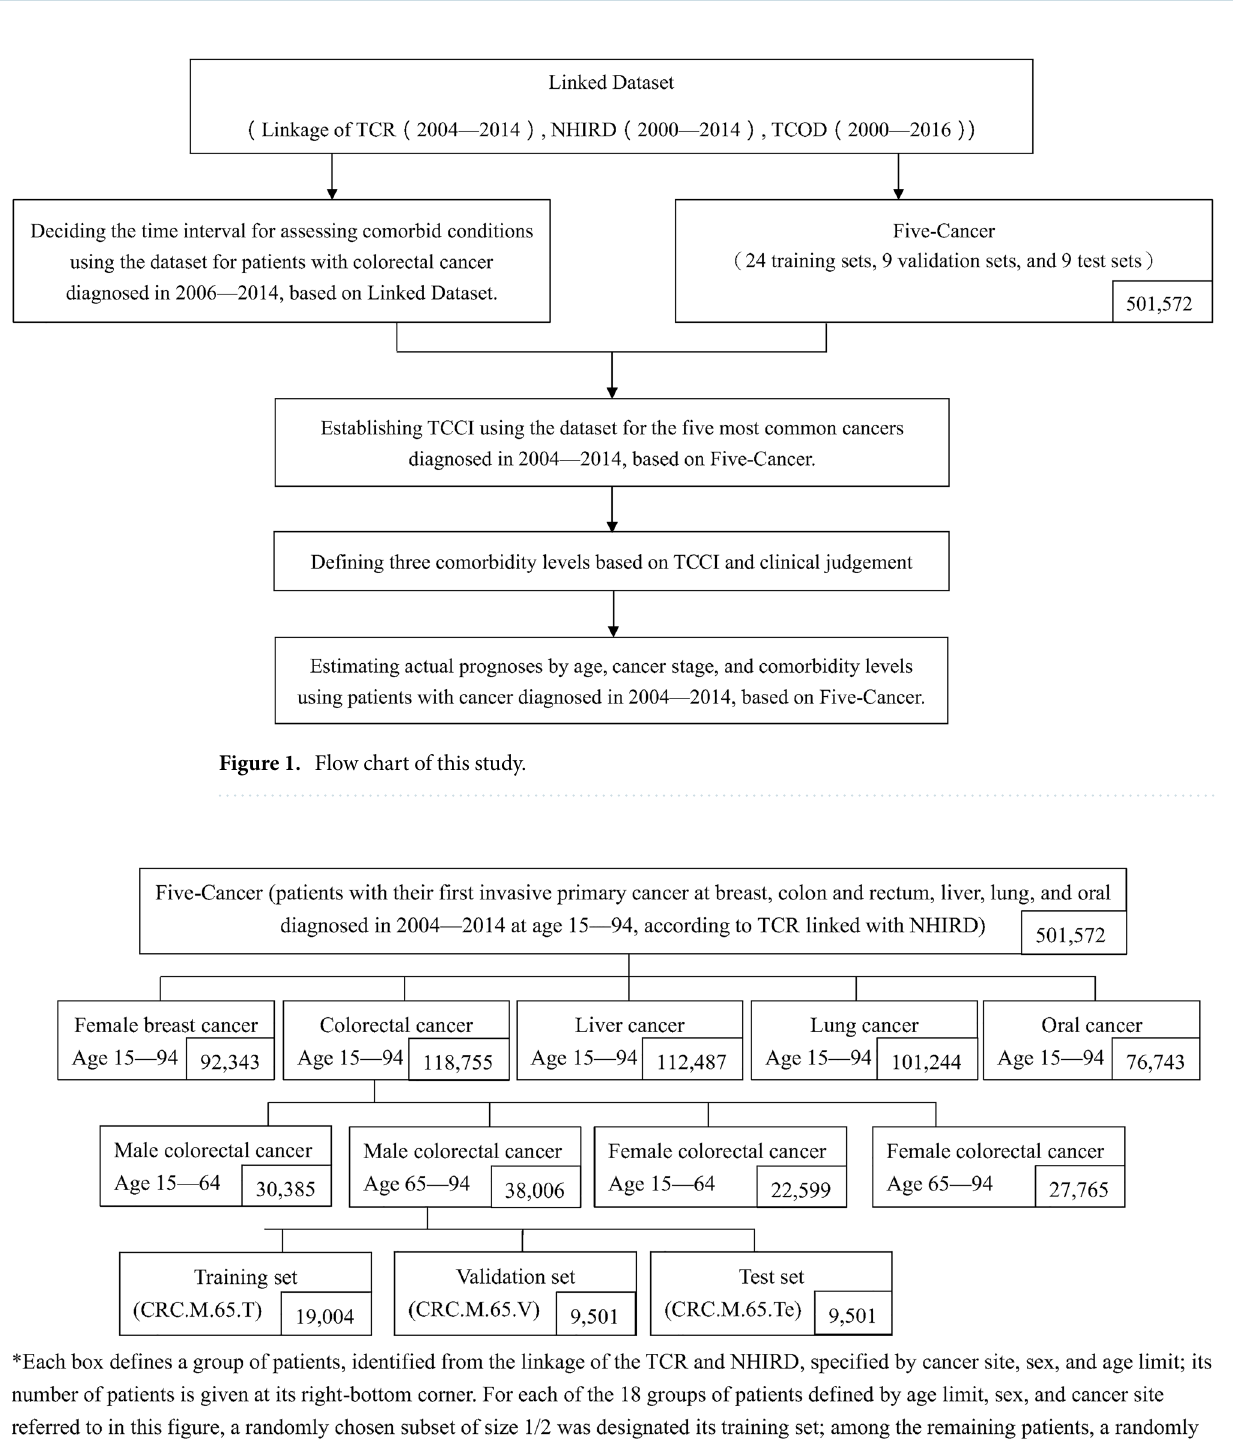
Figure 2. The forming of the 24 training sets, 9 validation sets, and 9 test sets in this